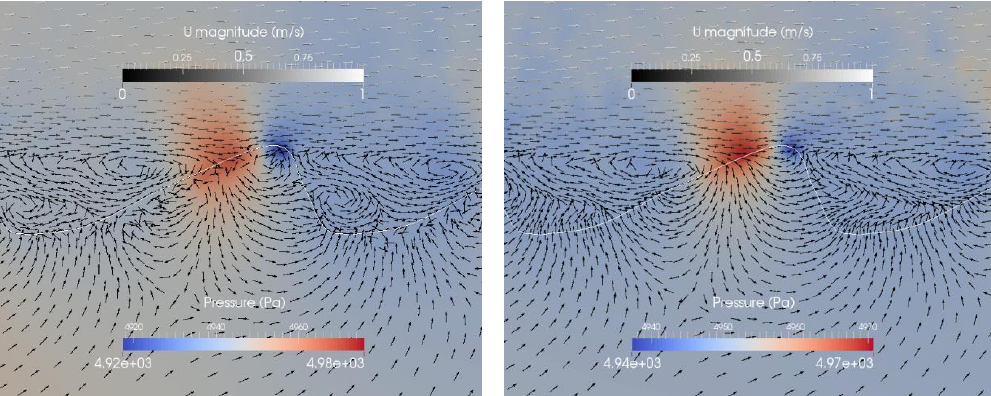
Figure 6. Pressure distribution and velocity vectors at a sandy ( left ) and gravel ( right ) ripple for case 1 (Table 1). The white line indicates the sediment-water interface. The colors indicate the pressure distribution. Please note that the scaling is different in the right and the left panel. The arrows indicate flow directions of the surface and the subsurface flow. To visualize the intensity of the flow U a grey is used.